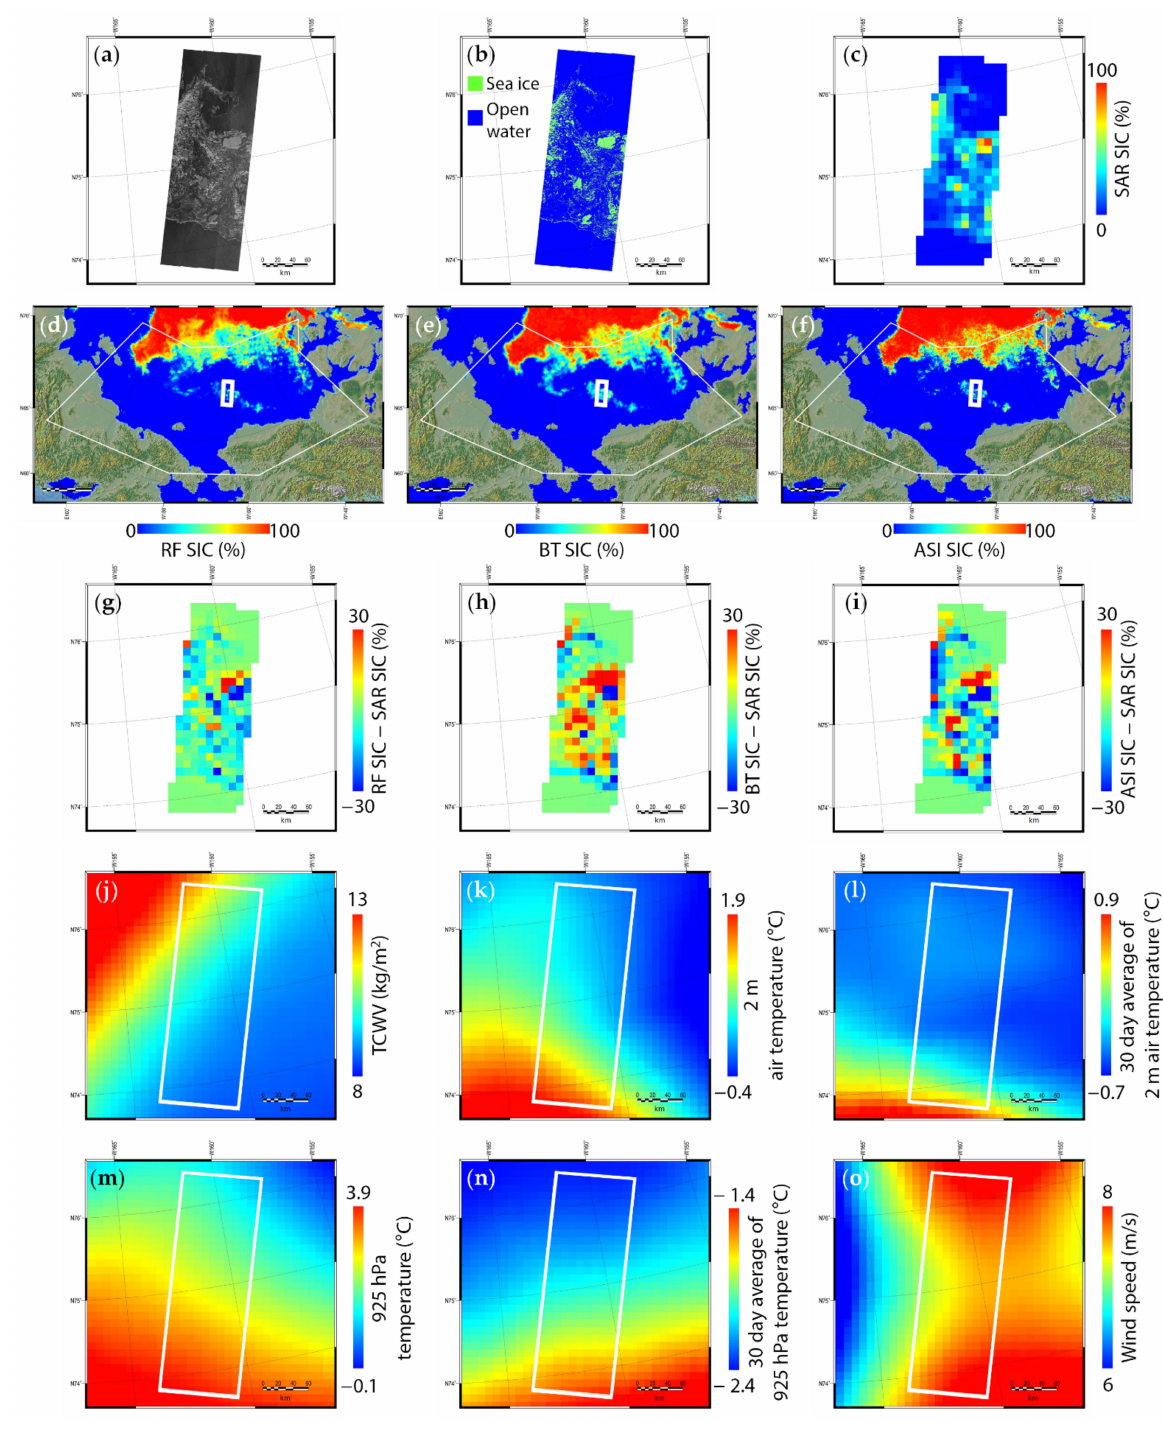
Figure 7. ( a ) KOMPSAT-5 EW SAR image acquired on 4 September 2015, and corresponding ( b ) ice/water map and ( c ) SIC with a grid size of 10 km. ( d – f ) RF, BT, and ASI SIC map for the Pacific Arctic Ocean (the white polygon) on the same date as the SAR image. The difference between SAR SIC and ( g ) RF, ( h ) BT, and ( i ) ASI SIC for the same area of the SAR image (the white box in ( d – f )). For the same date, ( j ) TCWV, ( k ) 2-m air temperature, ( l ) 30-day average of 2 m temperature, ( m ) air temperature at 925 hPa, ( n ) 30-day average of air temperature at 925 hPa and ( o ) wind speed. The white box in ( j – o ) represents the area of SAR